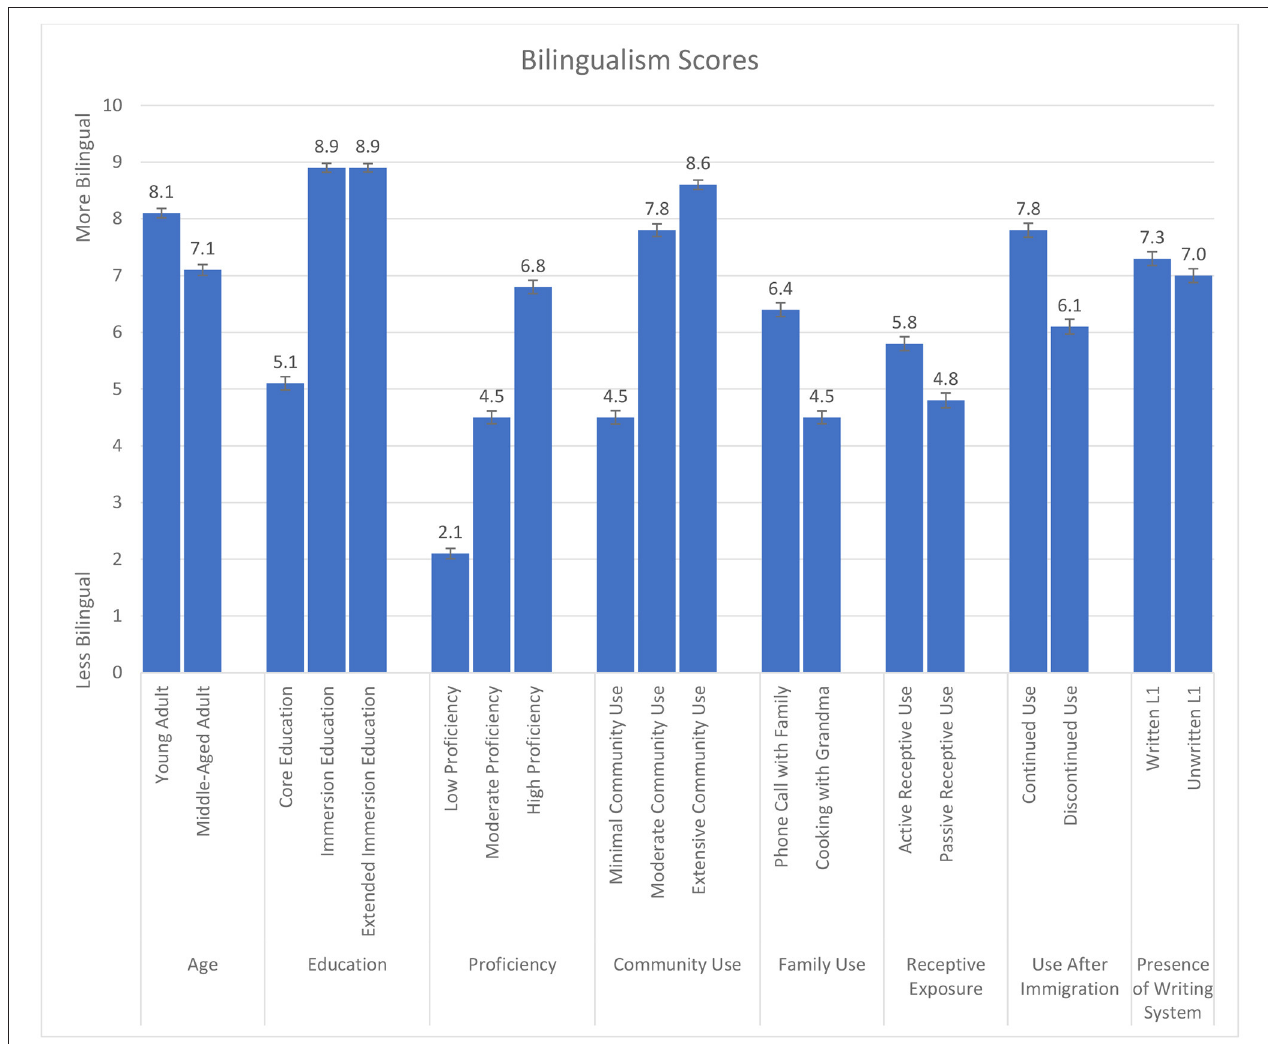
FIGURE 2 | Bilingualism scores (out of 10) illustrating the impact of each manipulated variable on the designation that an individual is bilingual.